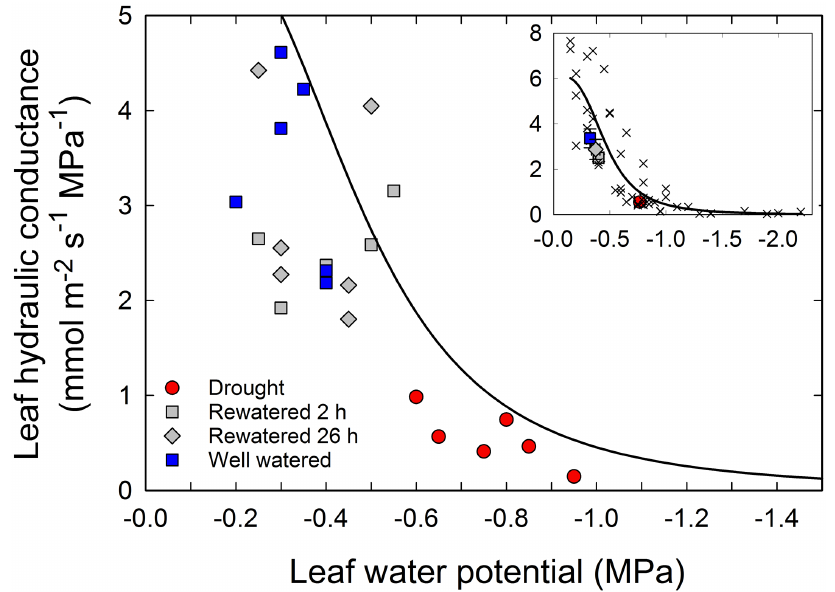
Figure 1. Effect of a change in water availability on leaf hydraulic conductance ( K leaf ) in Populustrichocarpa saplings. K leaf and the associated leaf water potential ( Y leaf ) were measured in 6 well-watered control plants (blue squares), 6 drought-stressed plants (red circles), and drought-stressed plants 2 and 26 h after rewatering (grey squares and diamonds, respectively). Each data point represents a single measurement of K leaf . The solid line shows the previously established vulnerability curve for K leaf . A 3 parameter logistic function was used for the curve fit: K leaf =6.154/[1 + ( Y leaf/ 0.469) 3.337 ]. An overview of the complete vulnerability curve is shown in the upper right corner of the figure. Individual measurements are shown as crosses; the mean values for each group ( 6 SE, n =6) are shown using the same symbols as explained